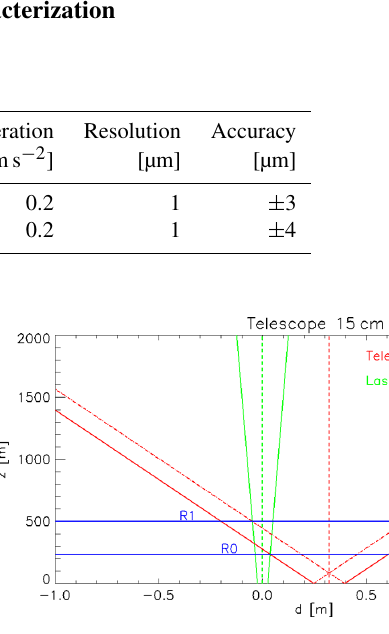
Figure 5. Schematic of the overlap between the telescope FOV (red) and the laser beam (green). Full overlap is reached inside the cone delimited by the dash–dotted lines. R 0 and R 1 heights are high- lighted by the horizontal